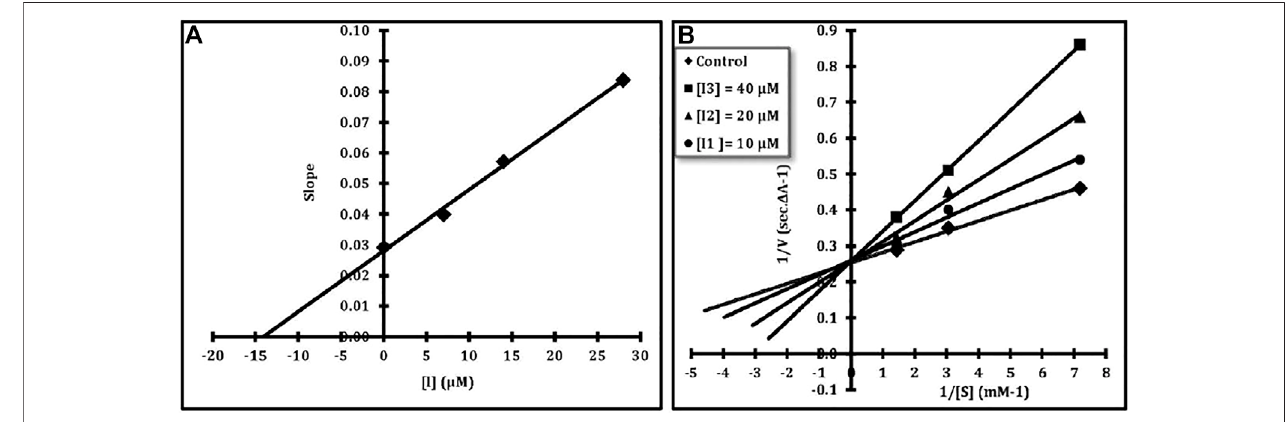
FIGURE 2 | (A) Lineweaver – Burk plot for the inhibition of BuChE by compound 8l in the presence of various concentrations of the substrate (BuTCh). (B) Secondary plot for calculation of steady-state inhibition constant of compound 8l (Ki (cid:1) 14.1 μ M).